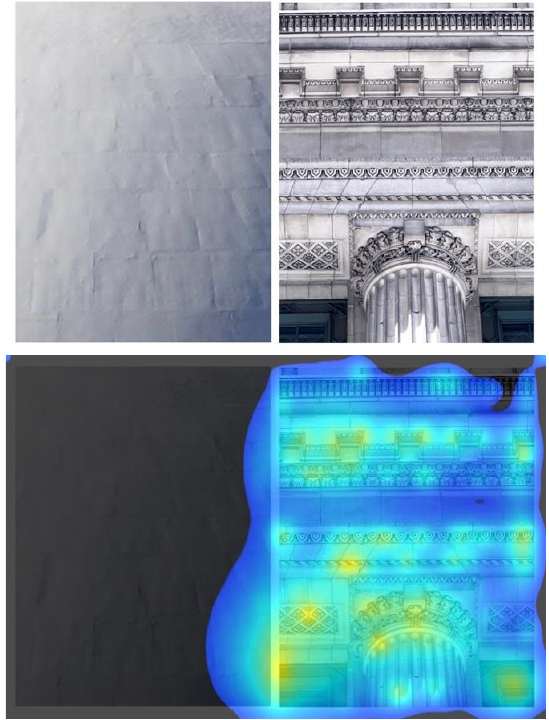
Figure 6. Comparative VAS heatmaps of zoomed-in images 1 and 12 processed together.